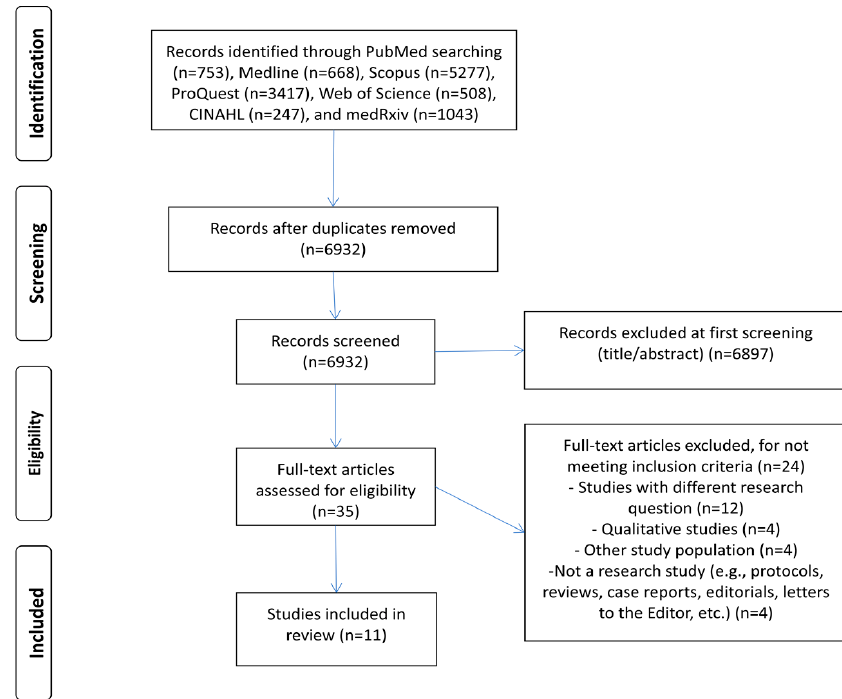
Figure 1. PRISMA flowchart diagram of the systematic review.